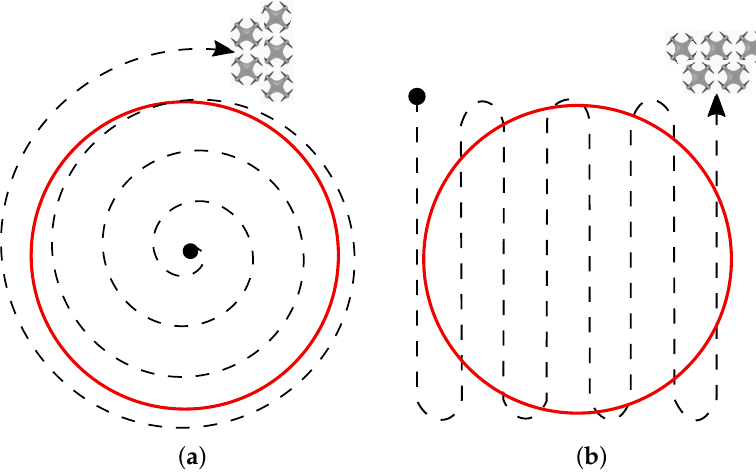
Figure 4. Area scanning strategies for the formation of unmanned aerial vehicles (UAVs). ( a ) Spiral pattern; ( b ) Back and forth